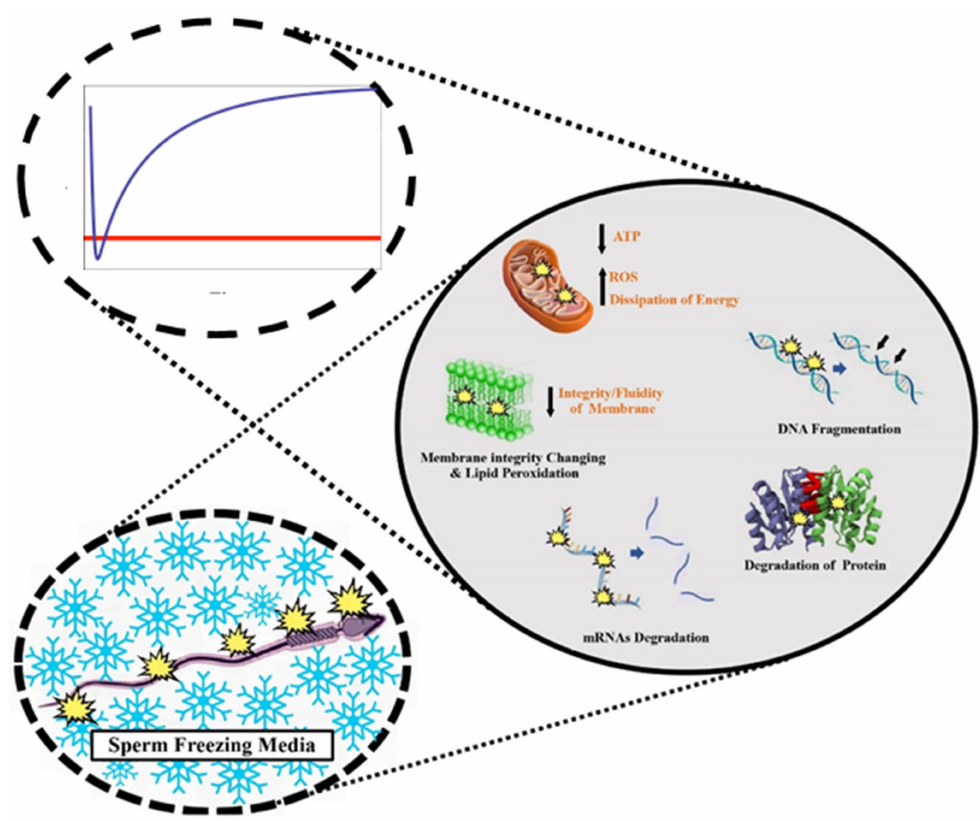
Figure 1. Mechanisms and foci of cryopreservation-induced injury ( right ) in sperm under two regimes: equilibration with and from high concentrations of cryoprotectant media which induces potentially damaging volume excursions (blue line representing volume, and red line representing an osmotic tolerance limit; top left ) and cooling in the presence and absence of extracellular ice ( bottom left